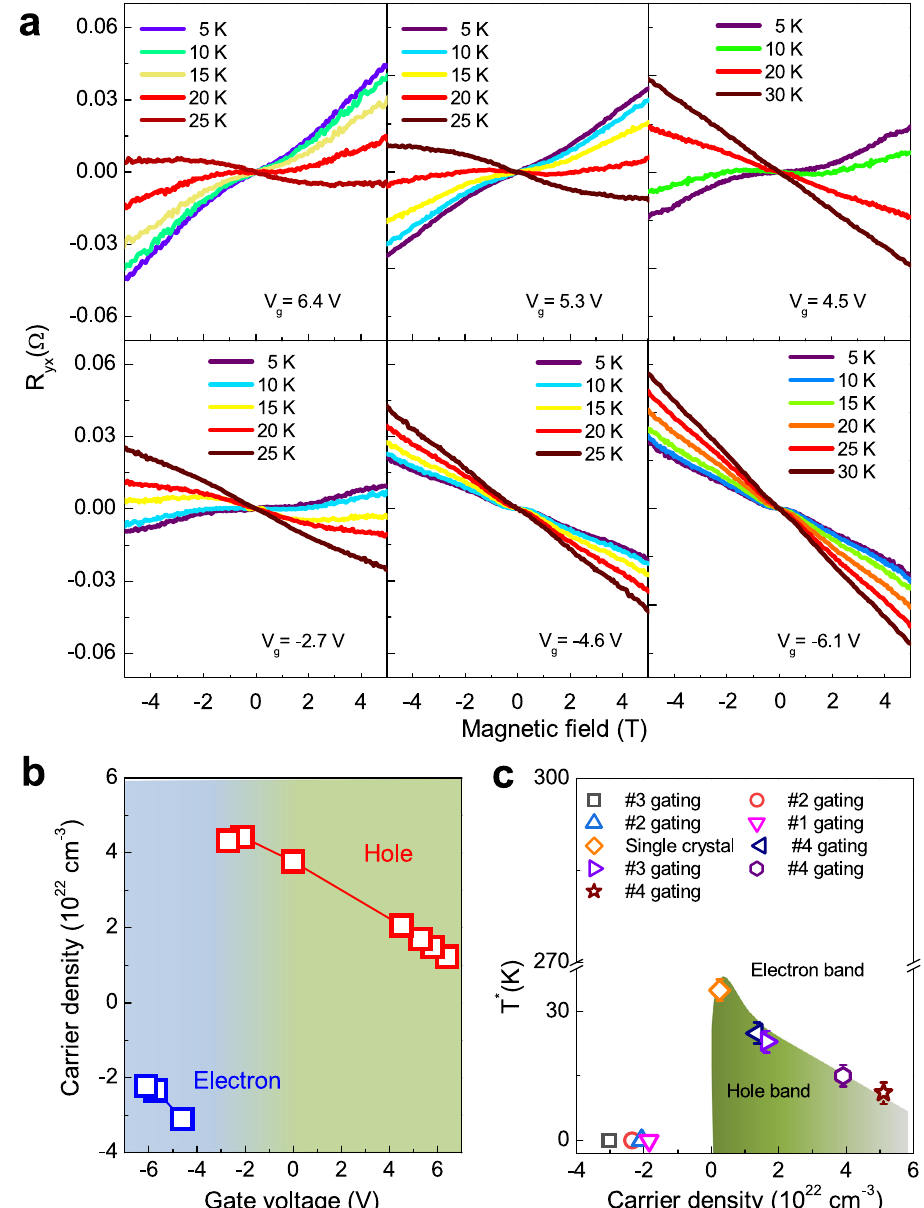
Fig. 2 | Gate-tuned Hall resistance and carrier density dependent band topol- ogy. a Temperature-dependent Hall effect in device #4 under different gating voltages. b Gate-dependent carrier density in device #4 at 5K. Sweeping the gate